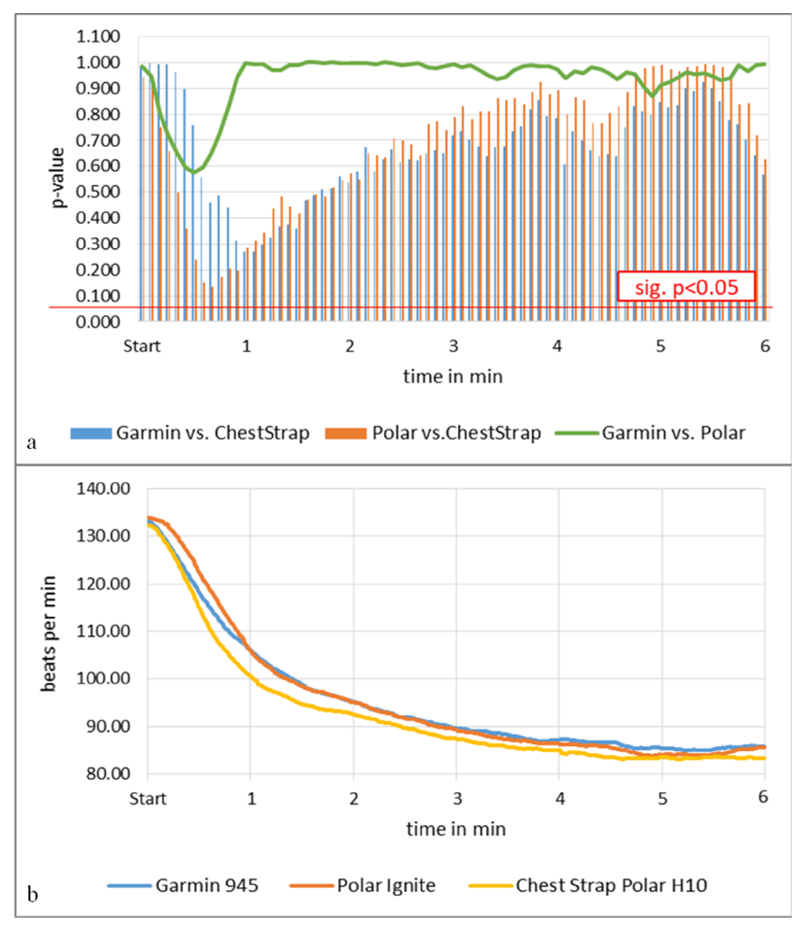
Figure 2. HR interval, 1.6 km interval run, p -value expressed in bars and corresponding HR graph at start/middle/end of each interval phase ( n = 36); min = minute, incr. = increasing run, subm. = submaximal run, trot = trotting run; * = p < 0.05.